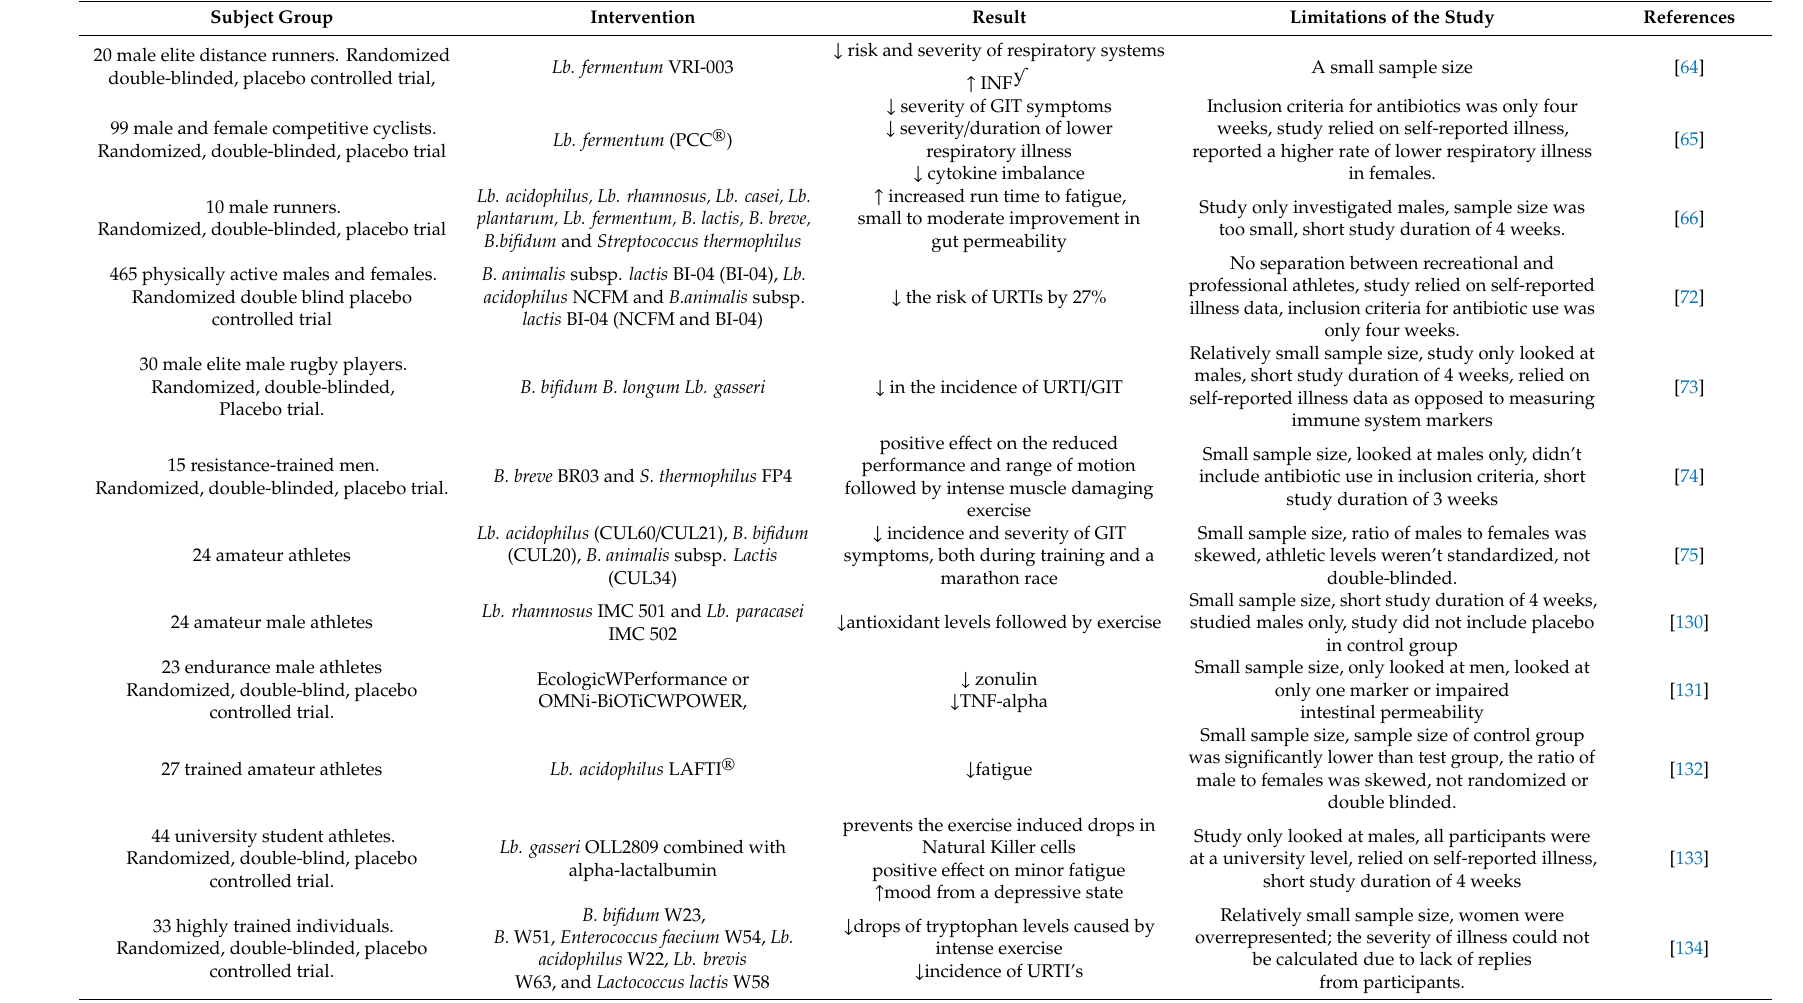
Table 3. Summary of studies using probiotics on physically active and athlete